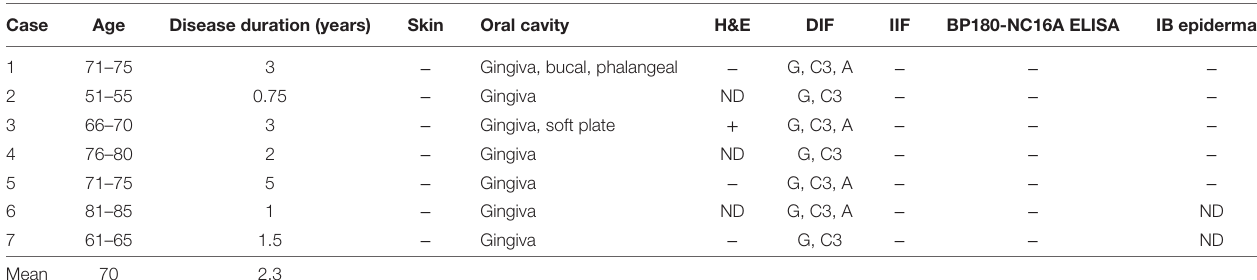
TaBle 1 | Summary of clinical information.